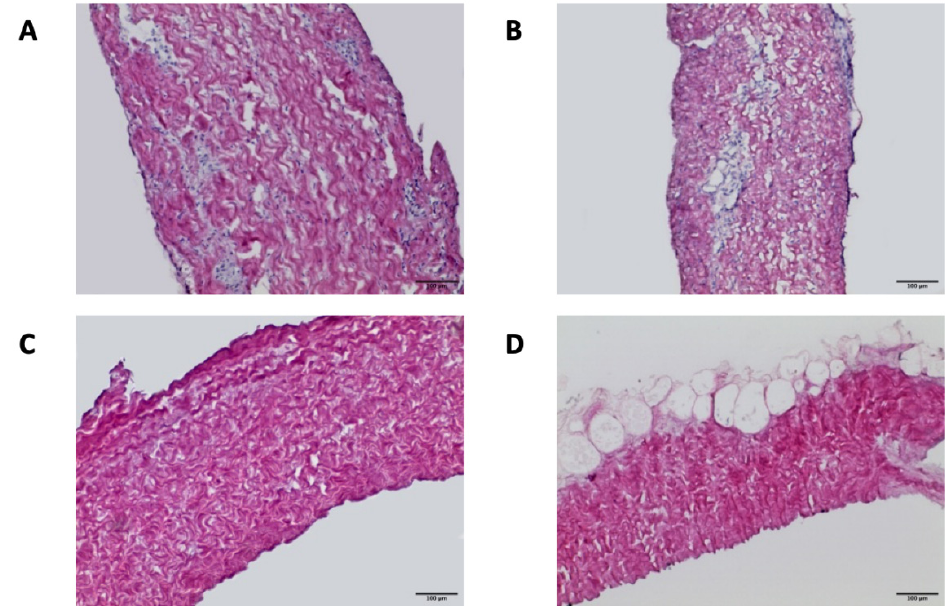
Figure 2. Hematoxylin and eosin staining of NBPs ( A ), DBPs ( C ), NPPs ( B ), and DPPs ( D ) samples (scale bar = 100 micron). Many nuclei are present in the native samples, while they are completely absent in the decellularized ones.